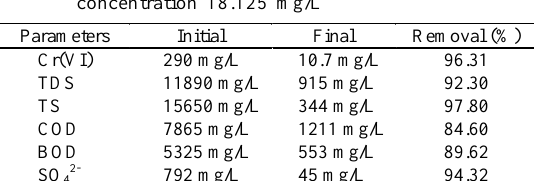
Table 7: The maximum reduction of Cr(VI) and other physico- chemical parameters in a tannery industry wastewater by isolated A. niger (S1) with an optimum pH of 3, optimum contact time (incubation time) of 7 days, optimum biomass (isolated fungi species) of 4.0 g of each fungi species and an aqueous Cr(VI) solution of